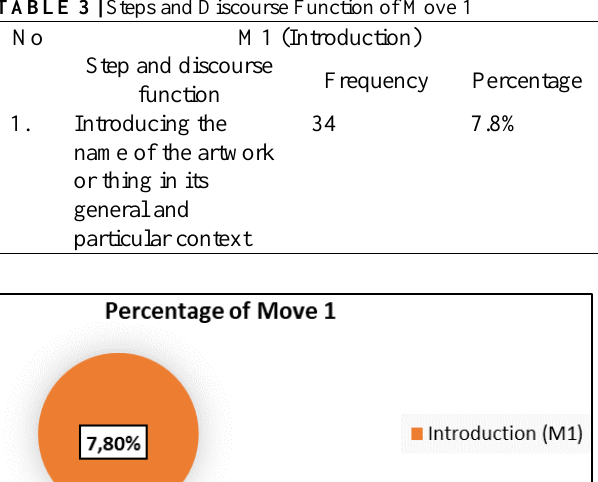
TABLE 3 | Steps and Discourse Function of Move 1